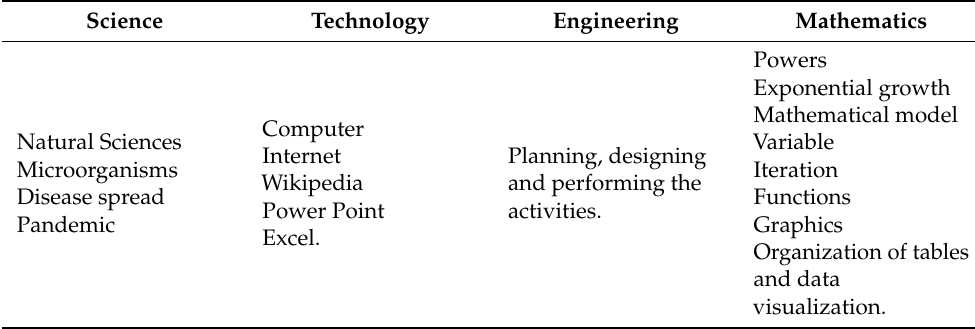
Table 10. STEM contents of the tasks implemented by teacher Elisa.